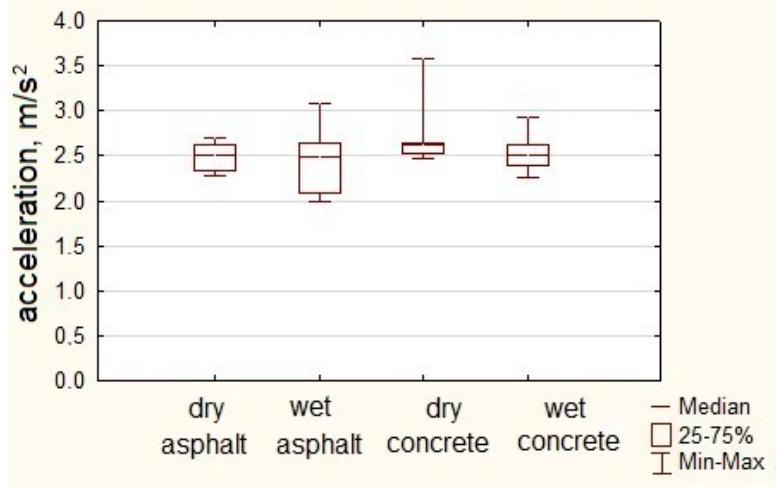
Figure 8. Longitudinal acceleration of coach during acceleration.